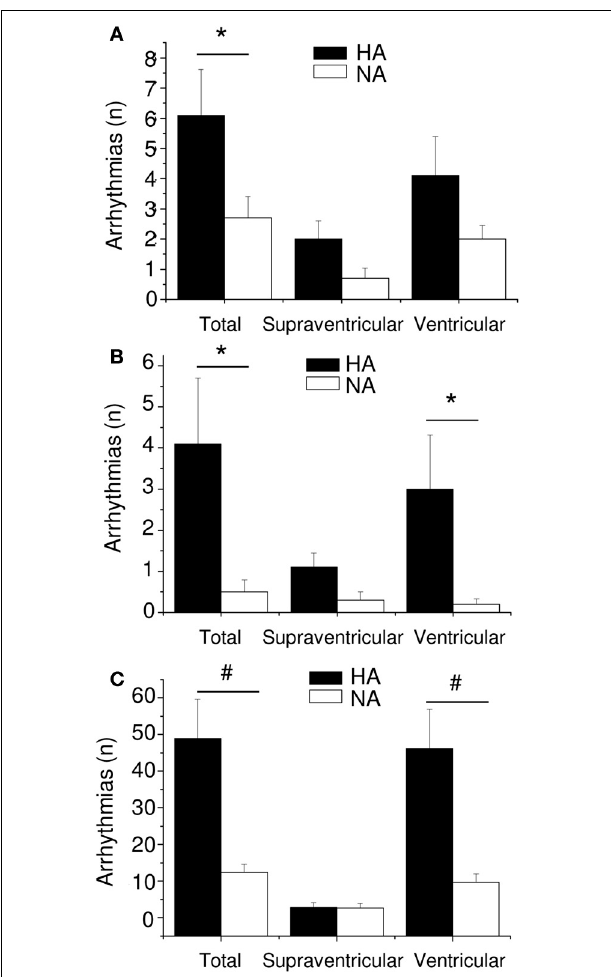
FIGURE 7 | Incidence of arrhythmias in high-aggressive (HA, n = 10) and non-aggressive (NA, n = 10) Wild-type rats during a restraint test (panel A), a psychosocial stress test (panel B) and following β -adrenoceptor pharmacological stimulation with isoproterenol (panel C). Values are reported as mean ± s.e.m. of number of events (n) per 15-min recording period. ∗ and # indicate a significant difference between HA and NA rats ( p < 0 . 05 and p < 0 . 01, respectively). Reproduced with permission from Carnevali et al.